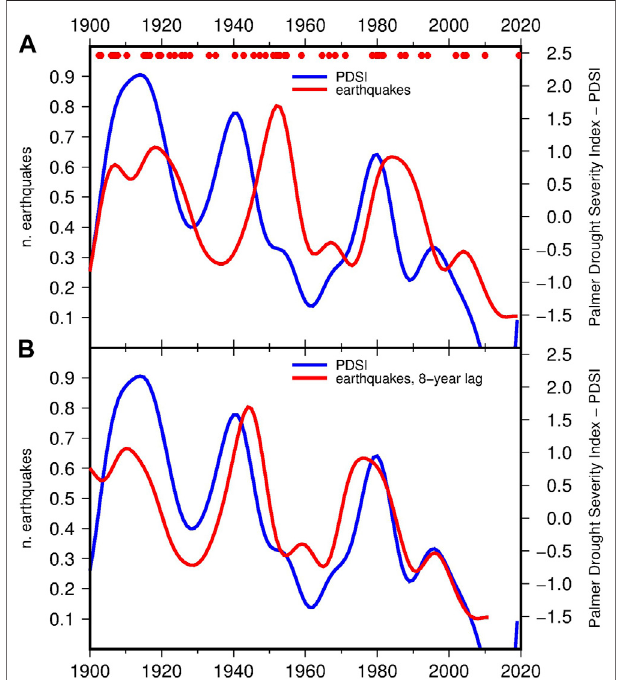
FIGURE5| TimedensityofMw ≥ 5.7earthquakesinSouthernCalifornia (red lines) and PDSI averaged over the climate zones 6 – 7 (blue lines). (A) curvesobtainedbyGaussiankernelsmoothingwithbandwidth parameter h (cid:1) 4 years; (B) the same curves with the earthquake time density anticipated by 8 years in order to maximize the correlation with PDSI (see the results for the data set 1 in Table 1 ). The dots indicate the time of occurrence of the earthquakes. FIGURE 6 | Bootstrap con fi dence intervals for the kernel regression of